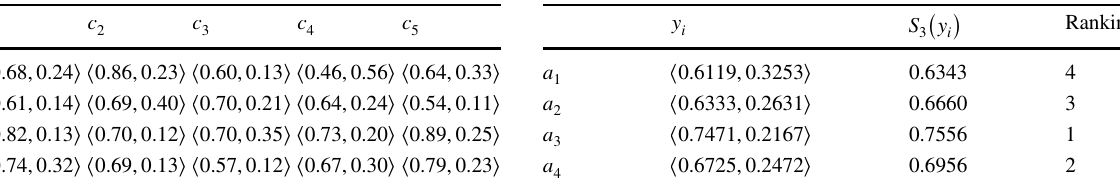
Table 7 Expert group decision matrix